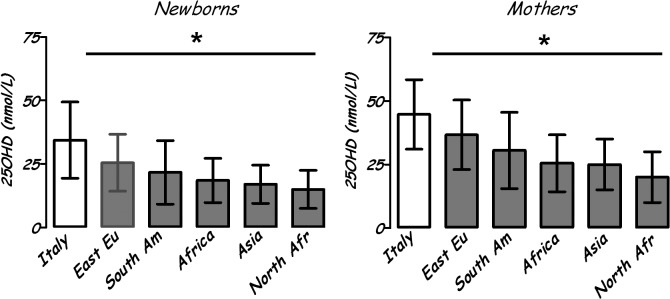
Vitamin D (25OHD) levels (nmol/L) in mothers and newborns by country of origin (mean ± SD).* = p<0.0001